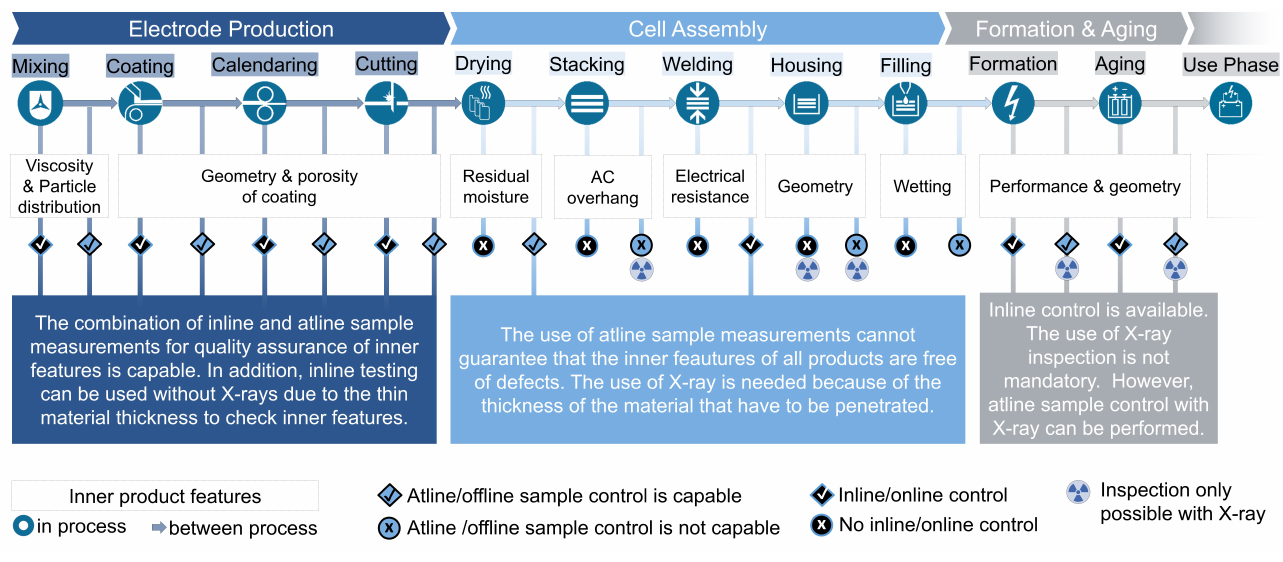
Figure 2. Overview of applications of X-ray inspection techniques in the production steps of a